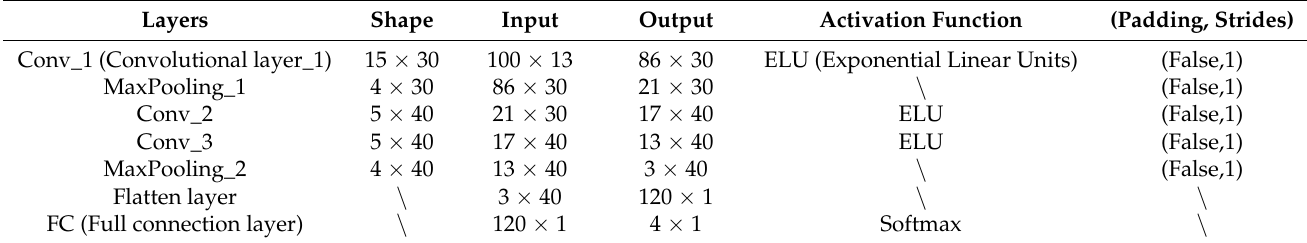
Figure 10. Structure of 1D-CNN. Table 3. Details of 1D-CNN.